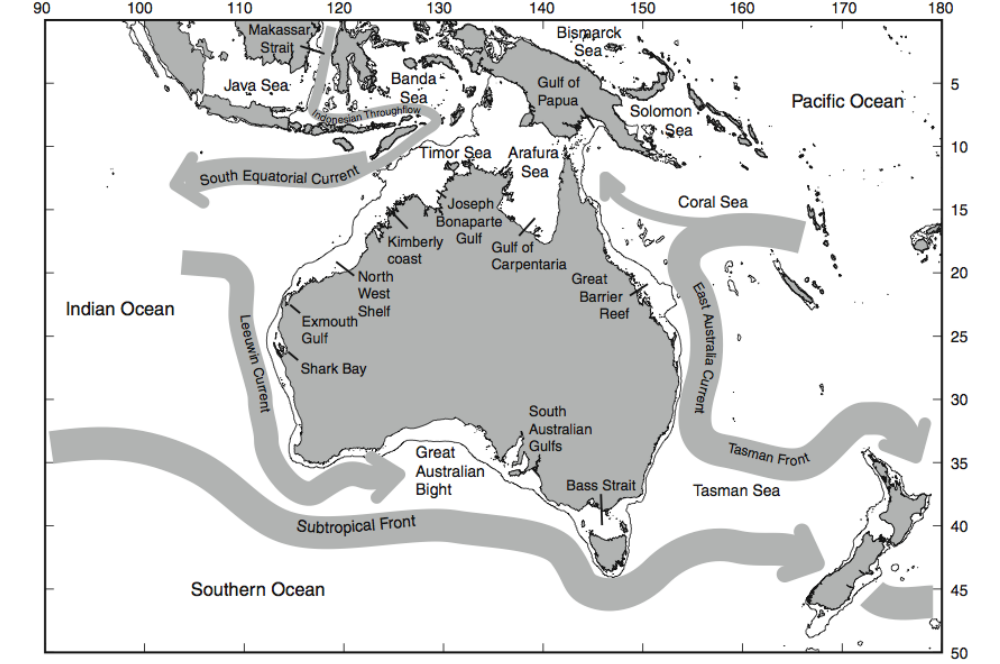
Fig. 1. Boundary currents around Australia, based on Poloczanska et al.